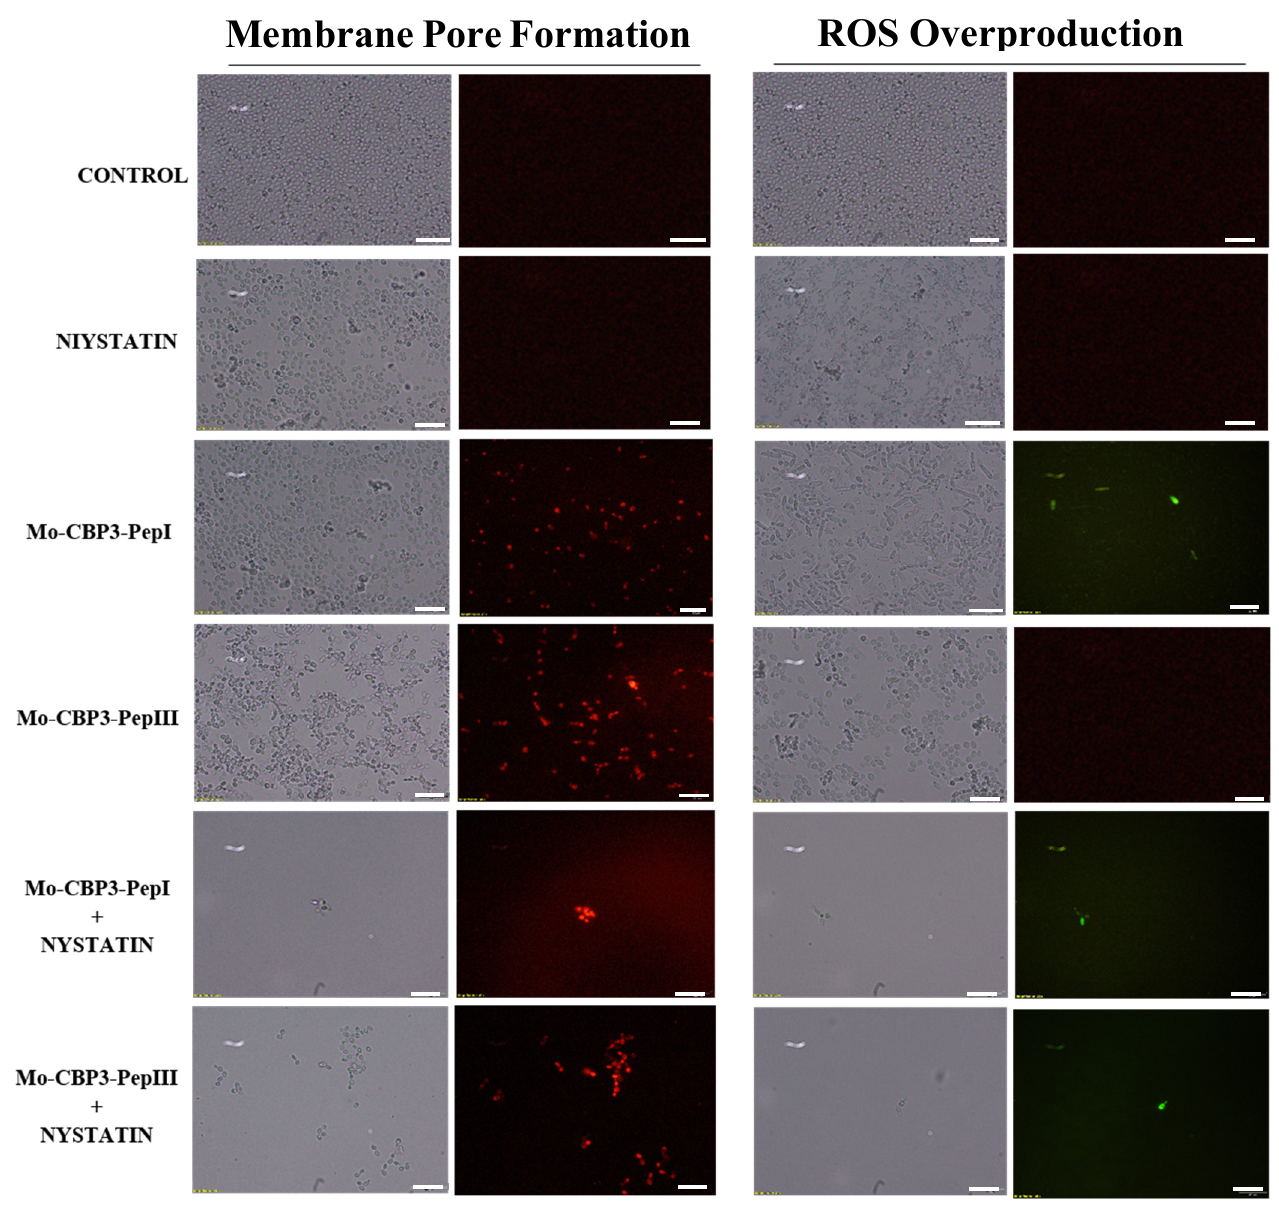
Figure 7. Fluorescence images showing membrane pore formation and ROS overproduction on inhibition of the biofilm of C. parapsilosis cells. Control solution of DMSO-NaCl, treated with Mo - CBP3-PepI and Mo-CBP3-PepIII at 50 μ g mL − 1 and synergistic activity of both peptides with NYS. Membrane pore formation was measured by the PI uptake assay, and ROS overproduction was detected using 2 ′ , 7 ′ dichlorofluorescein diacetate (DCFH-DA). Bars: 100 μ m. ROS overproduction is another mechanism employed by peptides to inhibit biofilm formation. The results showed that treatment of C. albicans cells with NYS or ITR did not induce ROS overproduction, whereas both peptides and their combination with NYS induced a slight production of ROS. None of the treatments induced ROS overproduction by C. parapsilosis biofilms (Figures